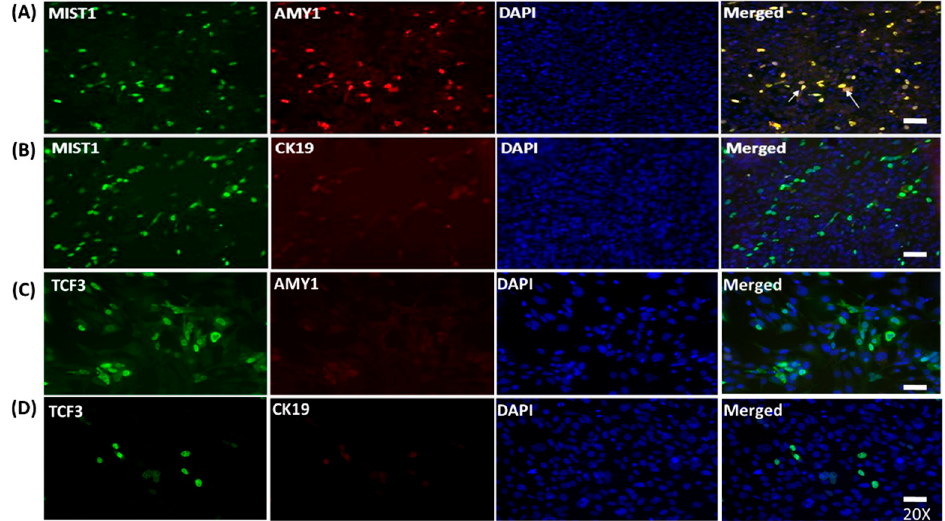
Figure 3. ICC to examine the expression of AMY1 and CK19 salivary gland markers in MIST1 and TCF3 transfected mMSC. MIST1 and TCF3 transfection efficiency was about 28–34% (green). Nuclear localization of MIST1 and TCF3 were confirmed by ICC. ( A , C ) MIST1 transfected mMSCs, but not TCF3 transfectants, were also stained positive for AMY1 (red). The merged image demonstrates the co-expression of MIST1 and AMY1 in the same cells (yellow). ( B , D ) Neither MIST1 nor TCF3 induced ductal cell marker CK19 expression. Magnification, × 200; scale bar, 20 μ m.